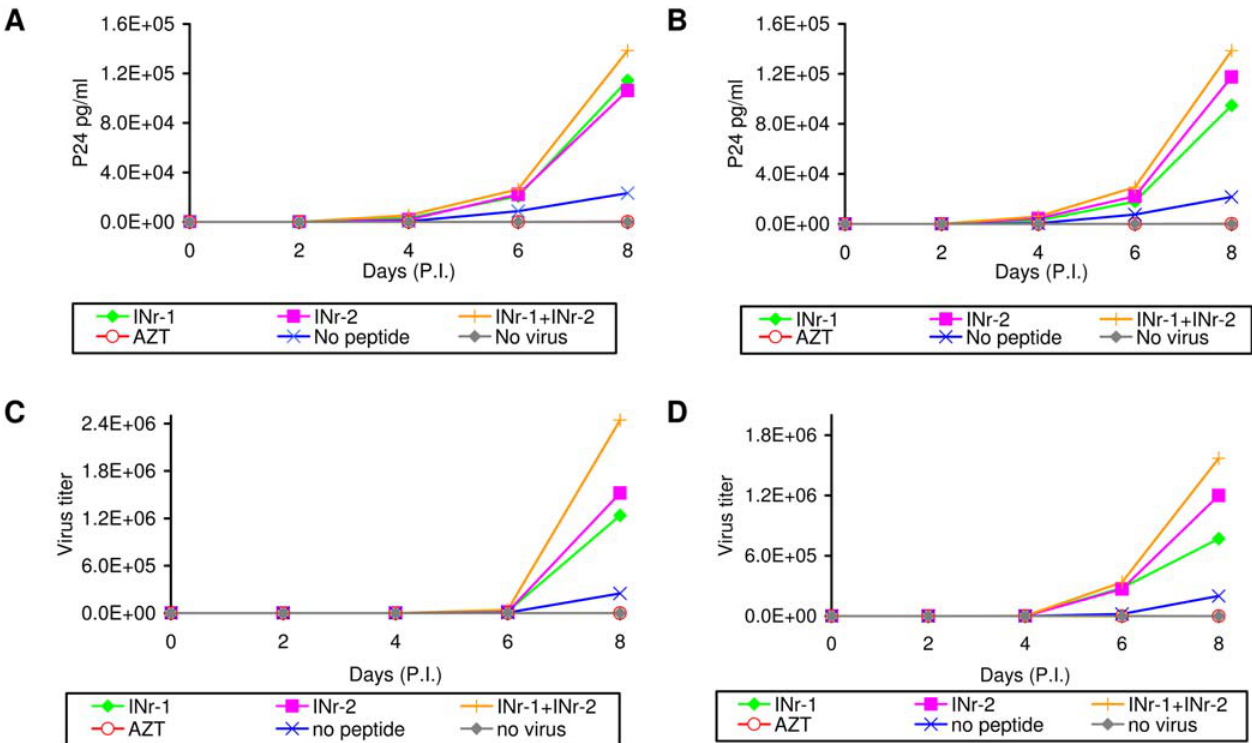
Figure 7. Stimulation of HIV-1 replication by the INrs. The INrs (12.5 m M) were incubated with H9 cells (A and C) and Sup-T1 lymphocyte cells (B and D) which were then infected with HIV-1 (MOI 0.01) as described in Materials and Methods. The amount of viral P24 (A and B) and virus titer (C and D) were determined every 2 days by ELISA and MAGI assay [49], respectively. All other experimental conditions are described in Materials and Methods. The concentration of AZT used was 2 m